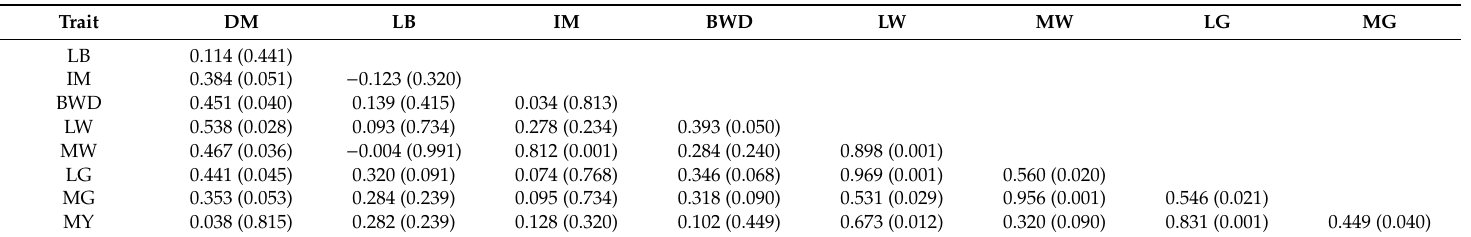
Table 6. Pearson correlation coe ffi cients between lactation performance characteristics of the doe and the growth of kits ( p